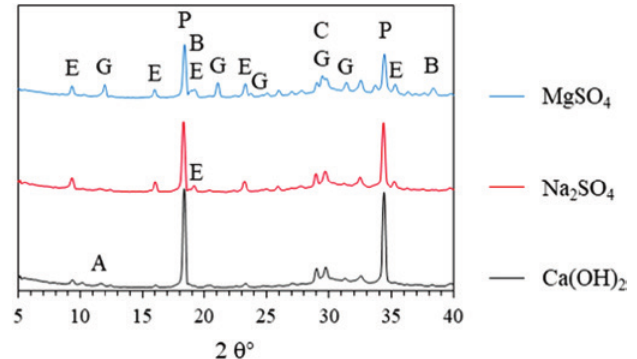
Figure 8 PC diffractograms after 20 weeks of exposure to Ca(OH) , Na SO and MgSO . 2 2 4 4 Monocarboluminate (A), brucite (B), calcite (C), ettringite (E), gypsum (G) and portlandite (P)